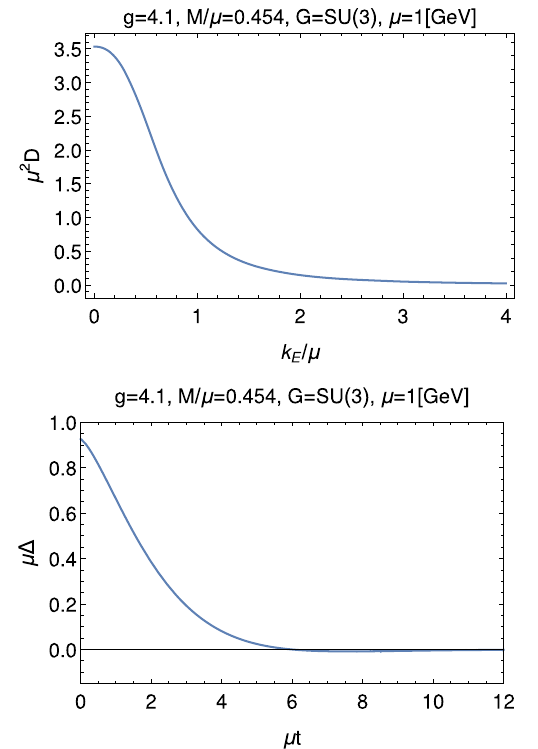
Fig. 7 The gluon propagator D and the Schwinger function (cid:6) at the physical point of the parameters g = 4 . 1, M /μ = 0 . 454: (top) gluon propagator μ 2 D as a function of k E /μ and (bottom) the Schwinger function μ(cid:6) as a function of μ t , where all quantities are made dimen- sionless using the rescaling of appropriate powers of μ